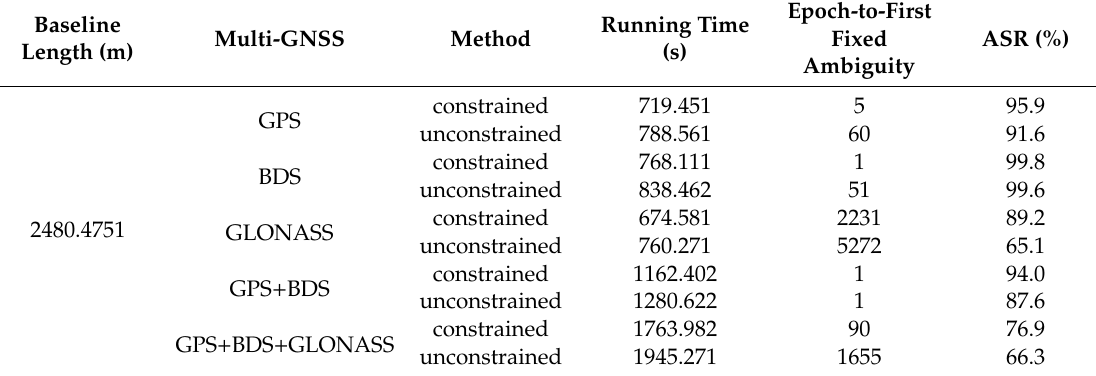
Table 1. Comparison of experimental results for the site of interest S012.